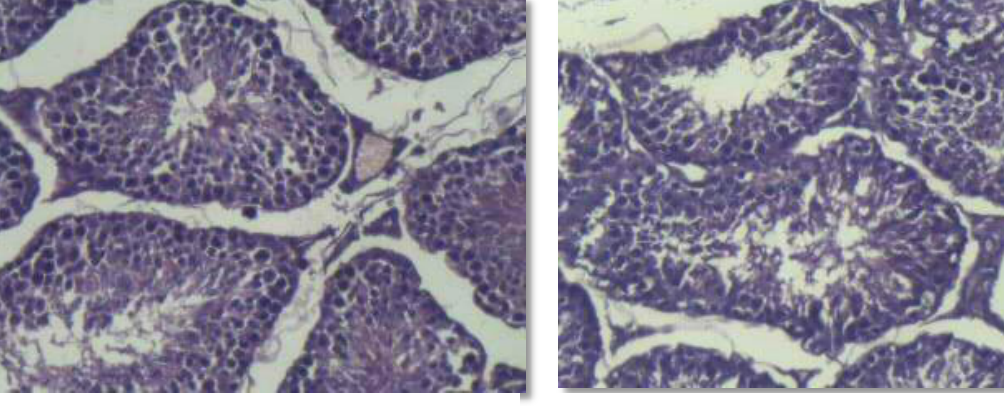
Figure (4): Histopathological section of ram testis (September) showing regenerative changes with maturity but still no numerous numbers of sperms inside the lumen of tubule. HE stain X200